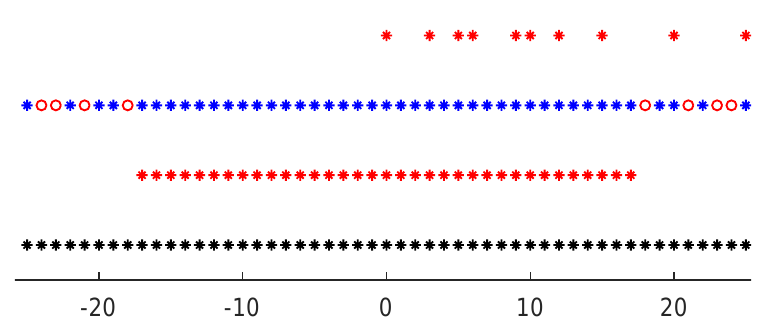
Figure 2. CPA Configuration ( ◦ Holes ∗ lags) (from the top) sensors in the corresponding CPA; the corresponding difference coarray; central contagious ULA; augmented coprime array.